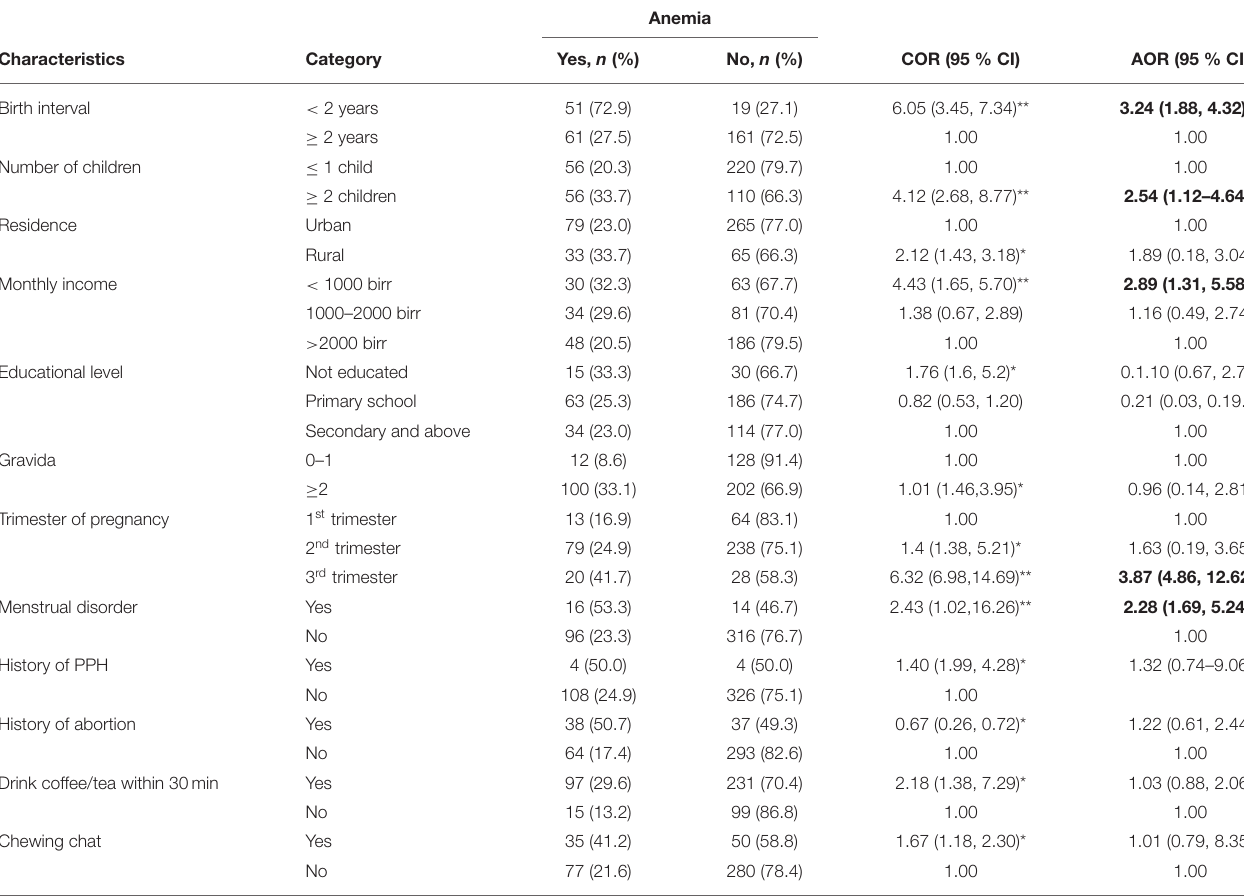
TABLE 6 | Factors associated with anemia among pregnant women attending ANC in a University hospital in Eastern Ethiopia, 2021 ( n = 442).